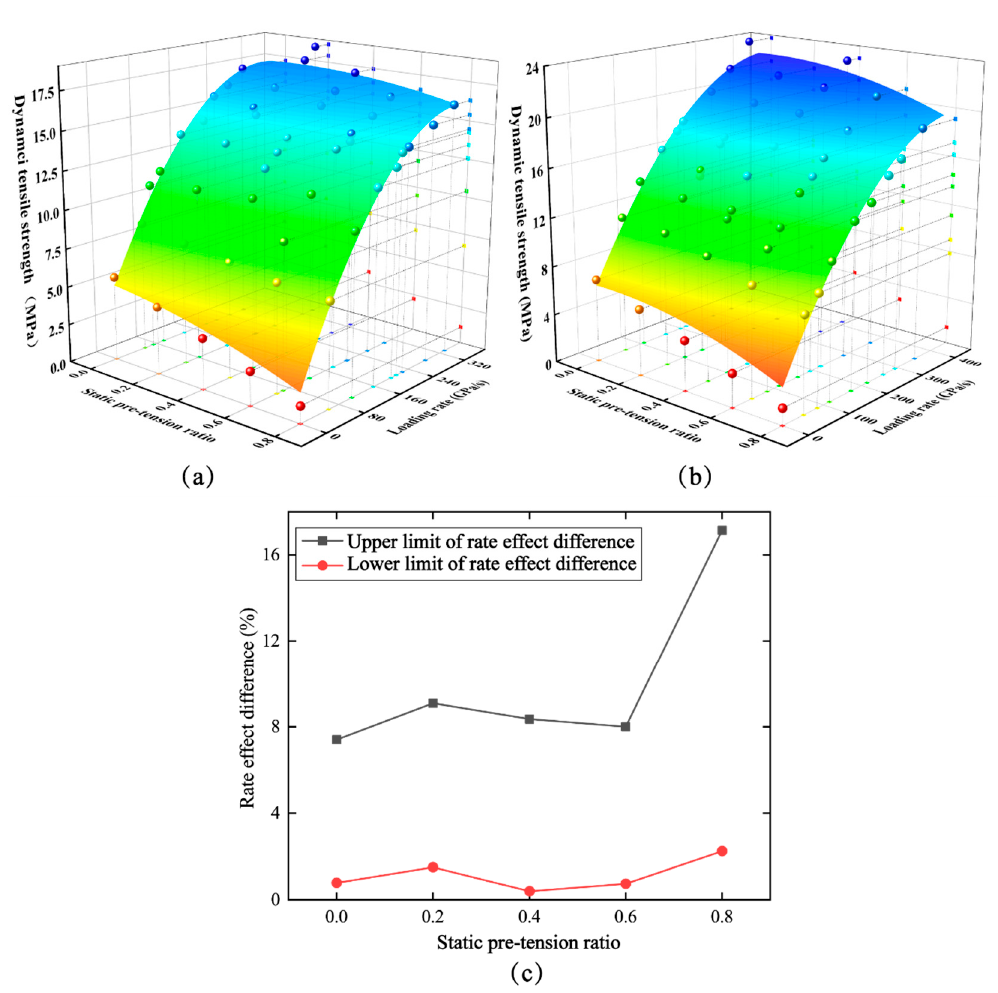
Figure 8. ( a ) The diversification of dynamic tensile strength under various external load conditions for natural rocks. ( b ) The diversification of dynamic tensile strength under various external load conditions for naturally saturated rocks. ( c ) The curve of the upper and lower limits of the rate effect difference of natural and naturally saturated rocks versus static pre-tension ratio.